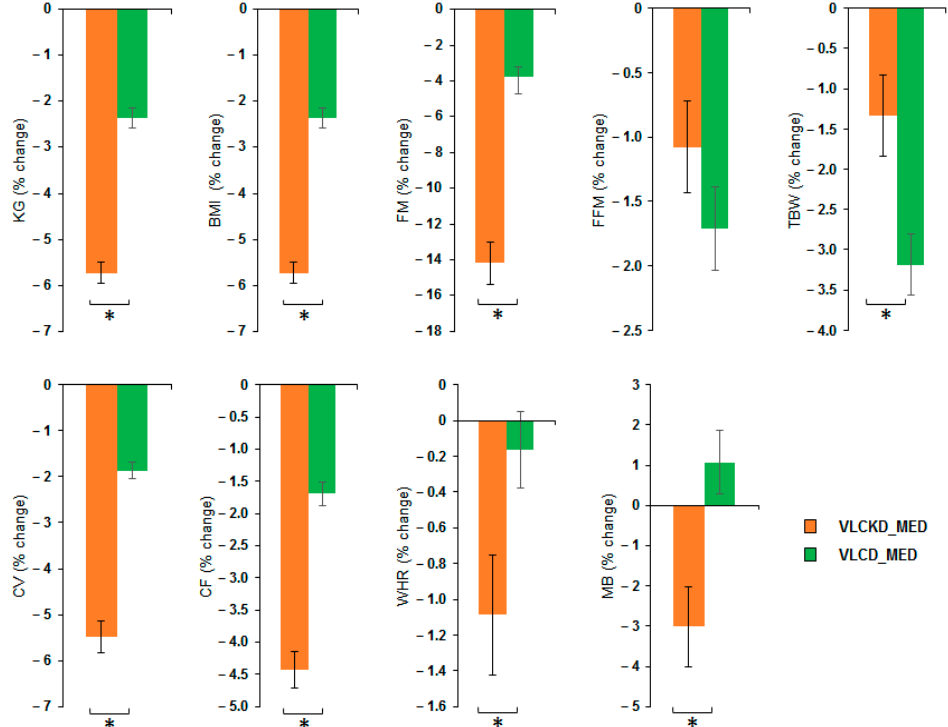
Figure 2. Percentage change of the anthropometrical and body composition variables after VLCKD_MED and VLCD_MED diet. The histogram depicts the % change (post-pre diet) in the level of weight (kg), BMI: body mass index (kg/m 2 ), FM: fat mass (kg), FFM: free fat mass (kg), TBW: total body water (kg), CV: waist circumference (cm), CF: hip circumference (cm), WHR: waist to hip ratio; MB: basal metabolism (kcal) for the group following the VLCKD_MED diet (orange bars) and VLCD_MED diet (green bars). Error bars depict the standard error of the mean. * depicts a significant difference, p < 0.05.